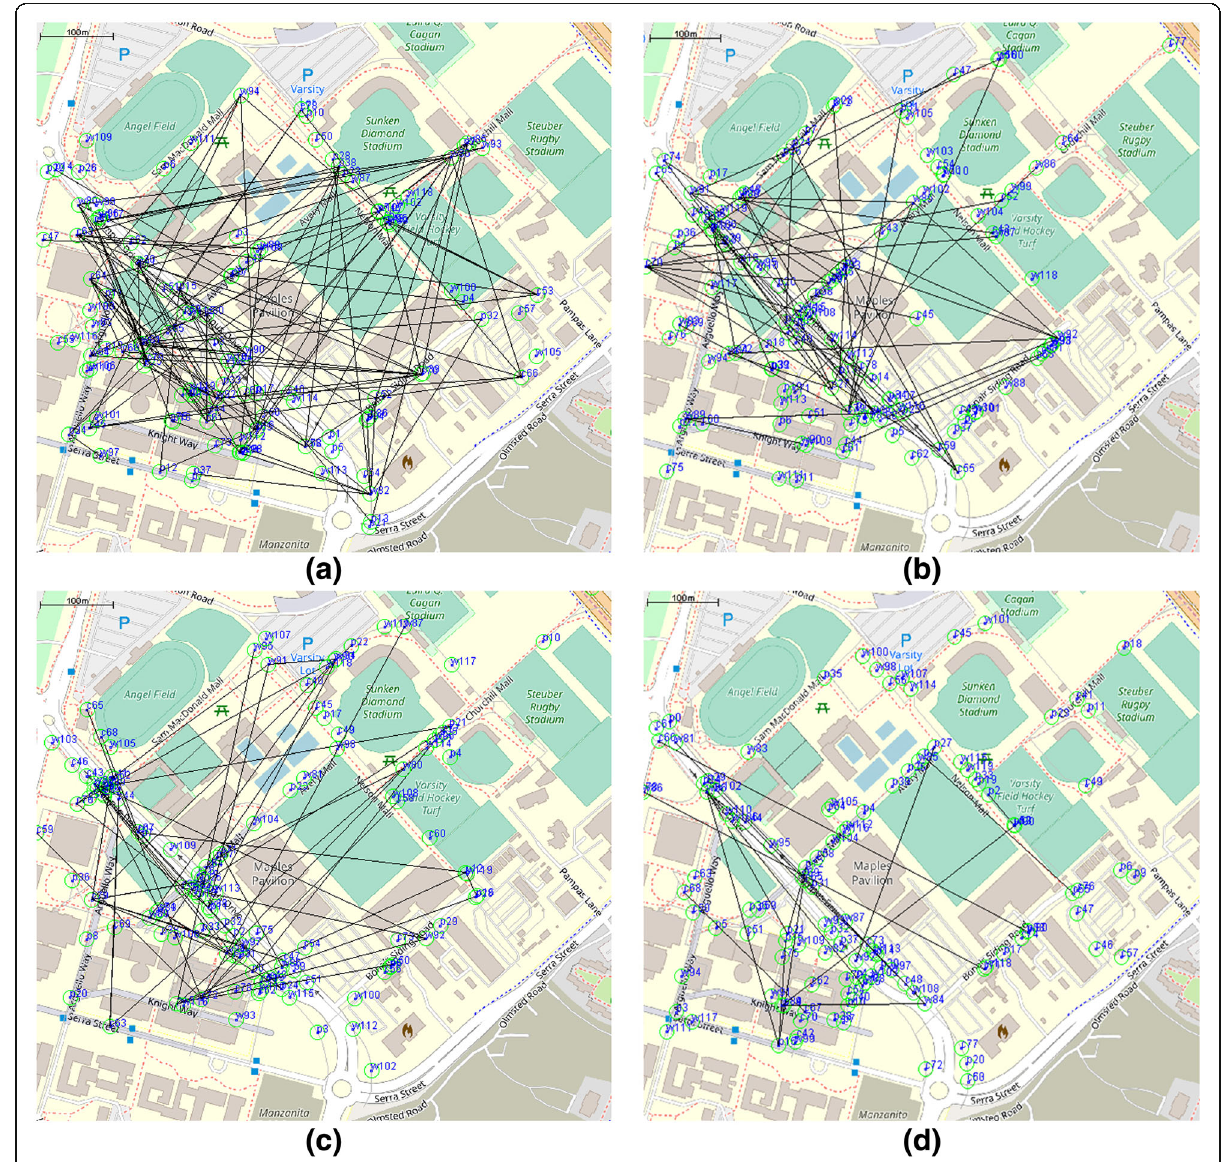
Fig. 3 Simulation experiment